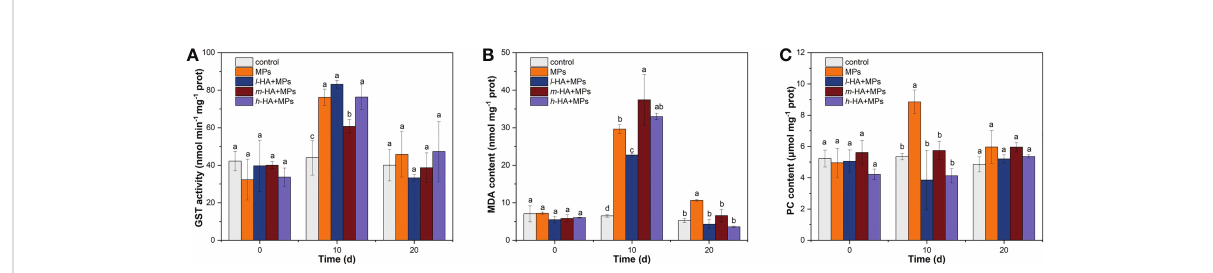
FIGURE 5 Changes in (A) GST activity, (B) MDA content, and (C) PC content in the liver of red tilapia following the treatments of MPs with different HA fractions at the end of the exposure and depuration periods. Error bars indicate ± SD (n=3). The different lowercase letters indicate signi fi cant differences among different treatments on each sampling time